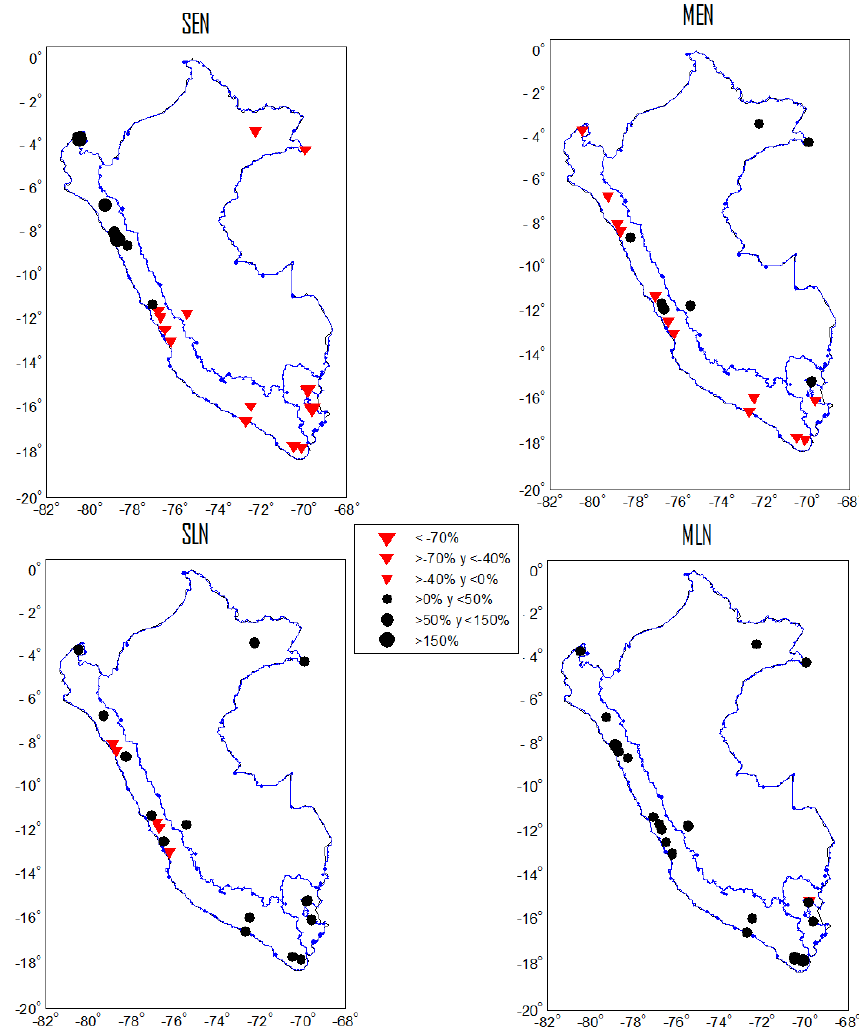
Figure 2. Spatial distribution of rate changes in mean discharges in relation to the historical series for the different events in all the stations. The Strong El Ni˜no years (SEN), the Moderate El Ni˜no years (MEN), the Strong La Ni˜na years (SLN) and the Moderate La Ni˜na years (MLN). 5 positive changes were constant from December to